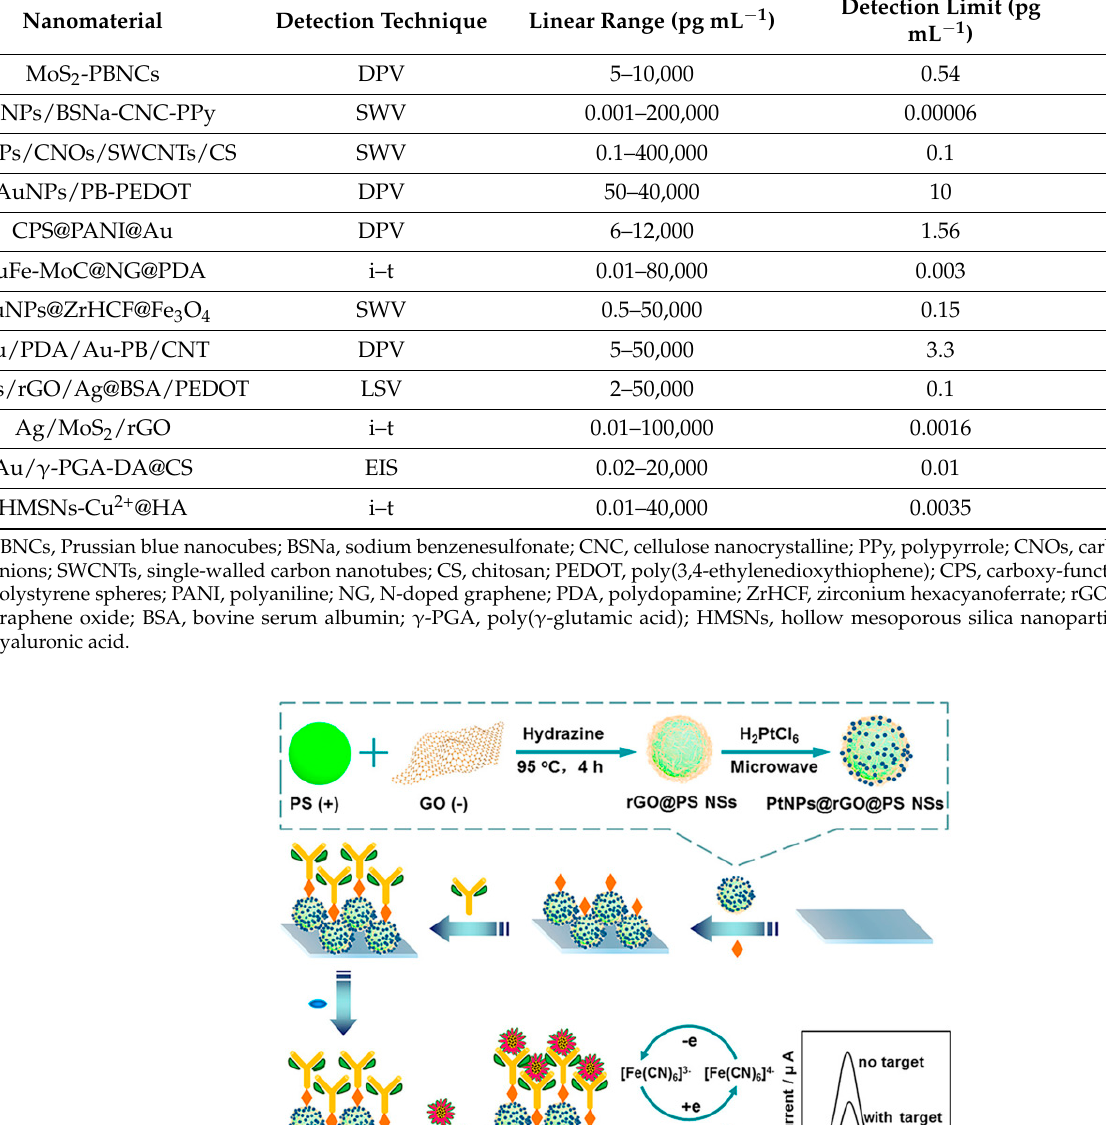
Table 1. Performance comparison of recently reported electrochemical immunosensors for CEA. Nanomaterial